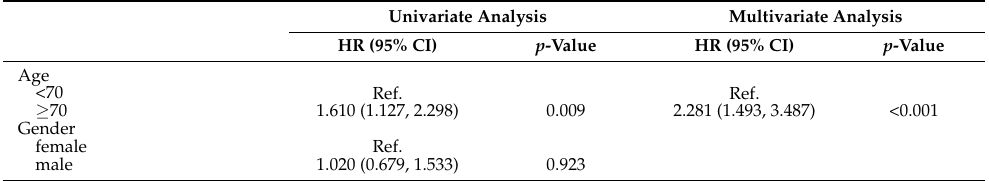
Figure 3. Evaluation of ML-based TSR with a 45.7% cut-off point as a prognostic variable in two cohorts. Kaplan–Meier survival curves for ( A ) RHWU and ( B ) TCGA cohort. Hazard ratio and 95% confidence interval for TSR and other clinicopathological features to predict survival in ( C ) univariate Cox and ( D ) multivariate Cox analyses. ML, machine learning. ***, p < 0.001; **, p < 0.01; *, p < 0.05. Table 2. Uni- and multivariate Cox analyses of prognostic factors in the TCGA cohort. Univariate Analysis Multivariate